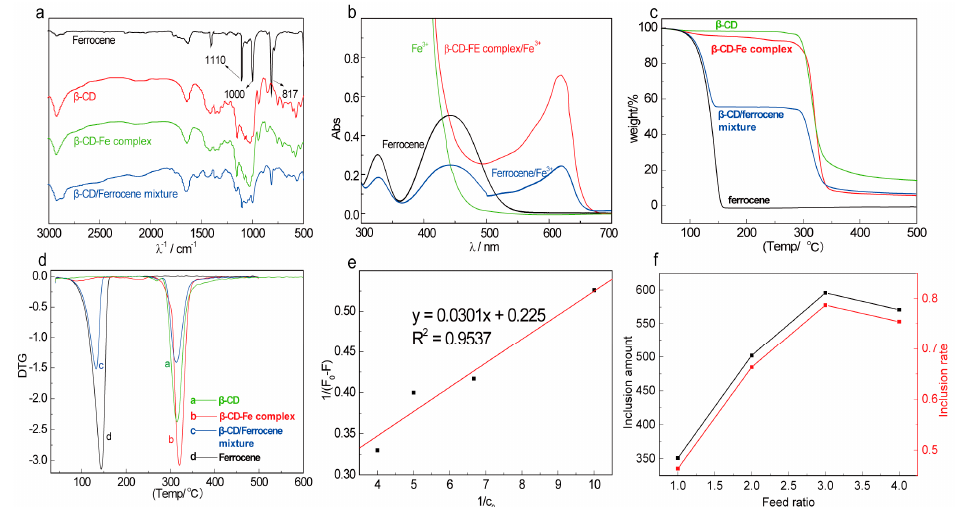
Figure 2. Characterization of β -CD-FE. ( a ) IR spectra of ferrocene, β -CD, the β -CD/FE mixture, and the β -CD-FE complex; ( b ) UV absorption spectra of different samples; ( c ) thermogravimetric curves of β -CD, the β -CD/FE mixture, the β -CD-FE complex, and ferrocene; ( d ) DTG curves of β -CD, the β -CD/FE mixture, the β -CD-FE complex, and ferrocene; ( e ) the standard curve for inclusion constants; and ( f ) the effects of feed ratios on the inclusion amount and the rate.